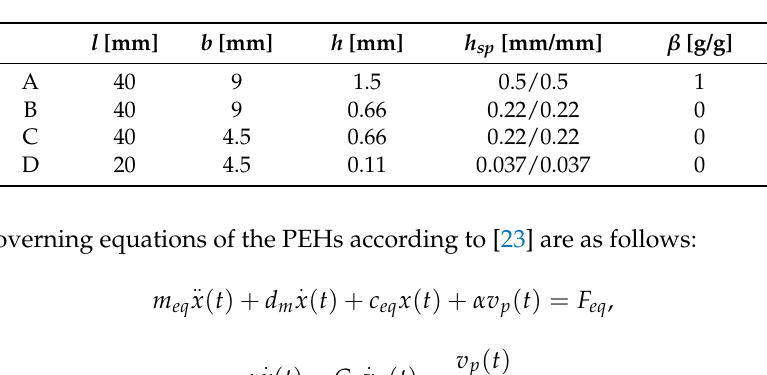
Table 4. Geometrical parameters of the